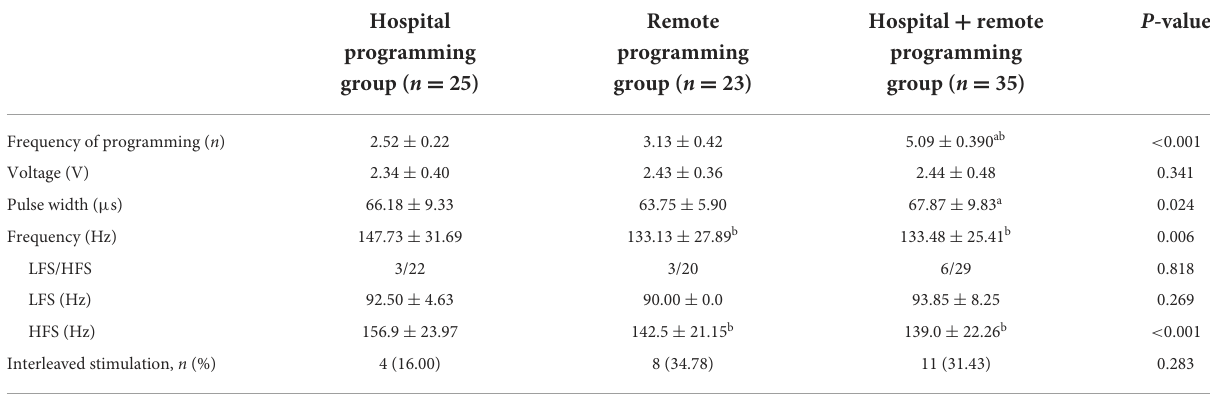
TABLE 3 Stimulation settings.